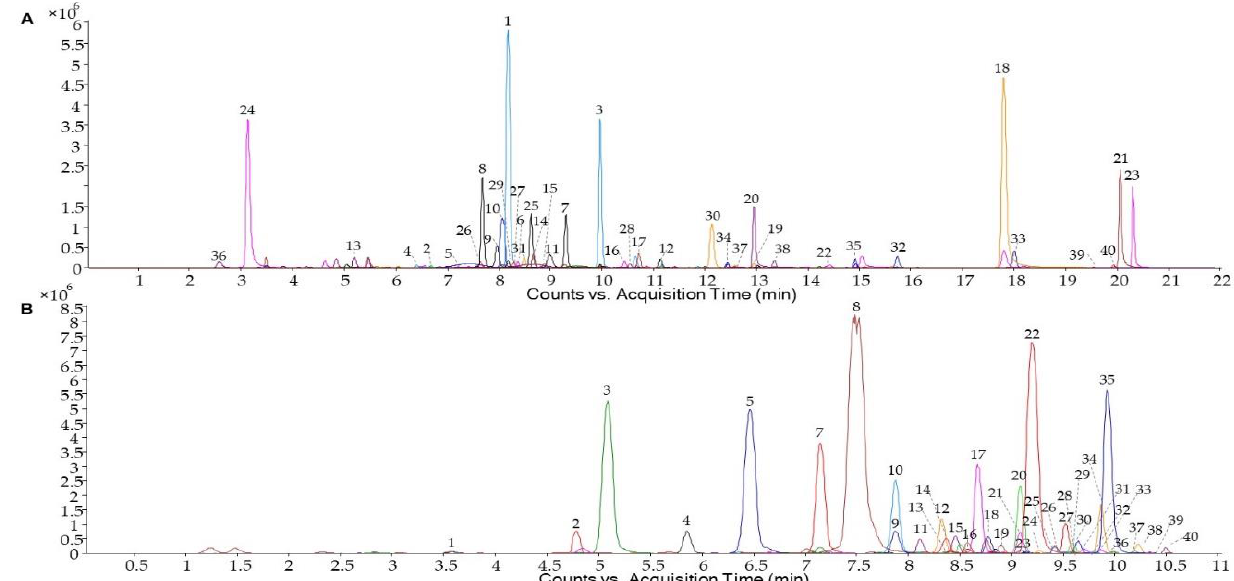
Figure 1. Phenolic profile of wine lees hydrolysate. Extracted ion chromatograms (EIC) of non-anthocyanin ( A ) and anthocyanin ( B ) phenolic compounds analyzed by UHPLC-(ESI-)-Q-TOF-MS and UHPLC-(ESI+)-Q-TOF-MS, respectively. Identified individual compounds are numbered according to Tables 2 and 3.